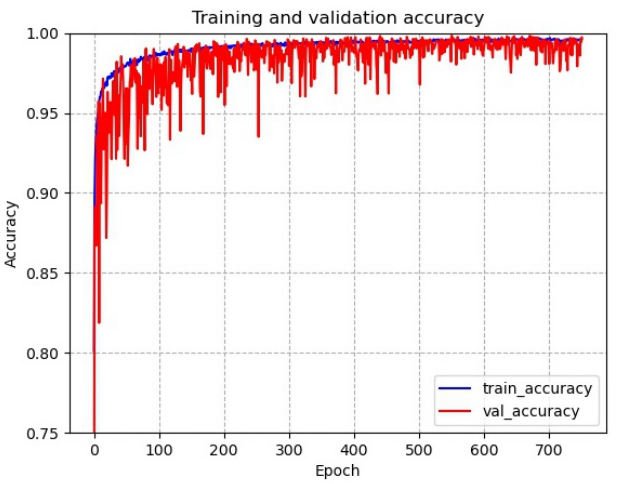
Figure 17. Accuracy of improved residual dilated convolution multilayer feature fusion network. (3) Performance comparison of two improved network models.